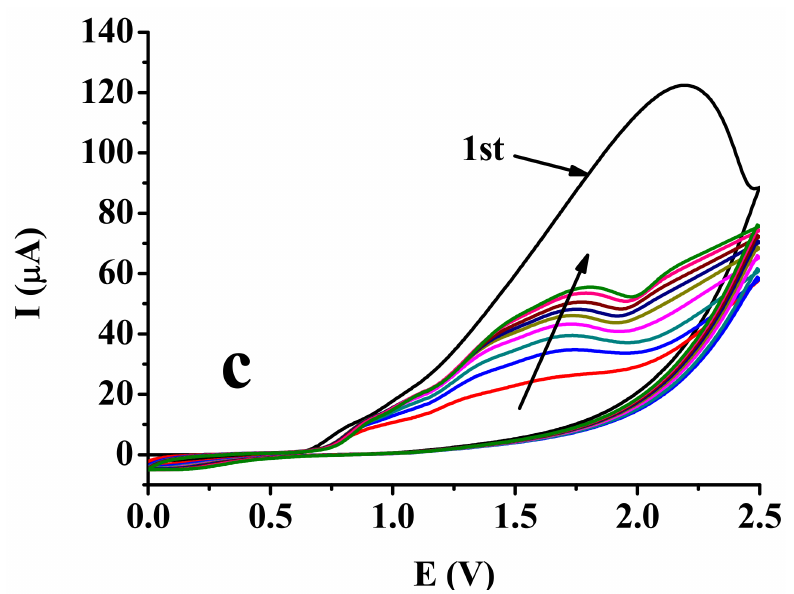
Figure 4. The ten consecutive cyclic voltammograms of 2-phenylphenol ( a ); 3-phenylphenol ( b ); 4- phenylphenol ( c ) in mesityl oxide ( c = 50 mM, supporting electrolyte = 70 mM TBAP, and v = 0.1